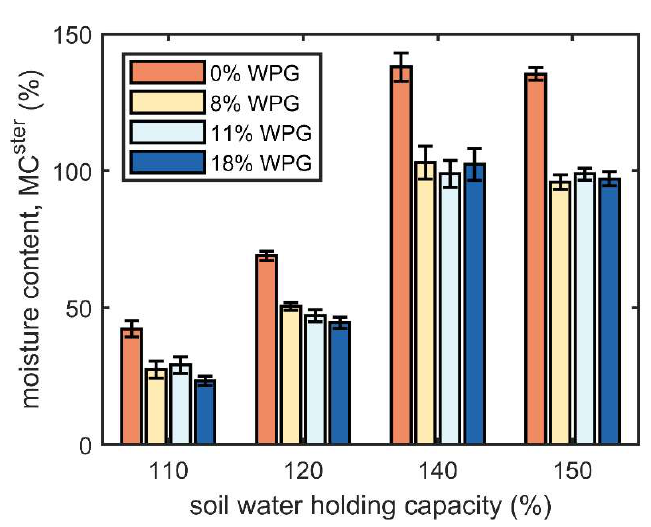
Figure 3. Effect of the soil water holding capacity on the wood moisture content after 8 weeks with no fungus present ( MC ster ). The error bars represent the standard deviation from five replicates.